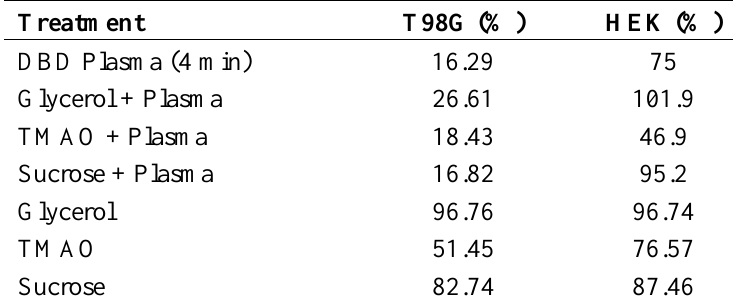
Table 2. Percentage viability after 72 h of treatment. T98G cells were treated with a osmolytes at a 75 mM concentration with or without DBD plasma for 4 min. All values are means of three independent experiments.